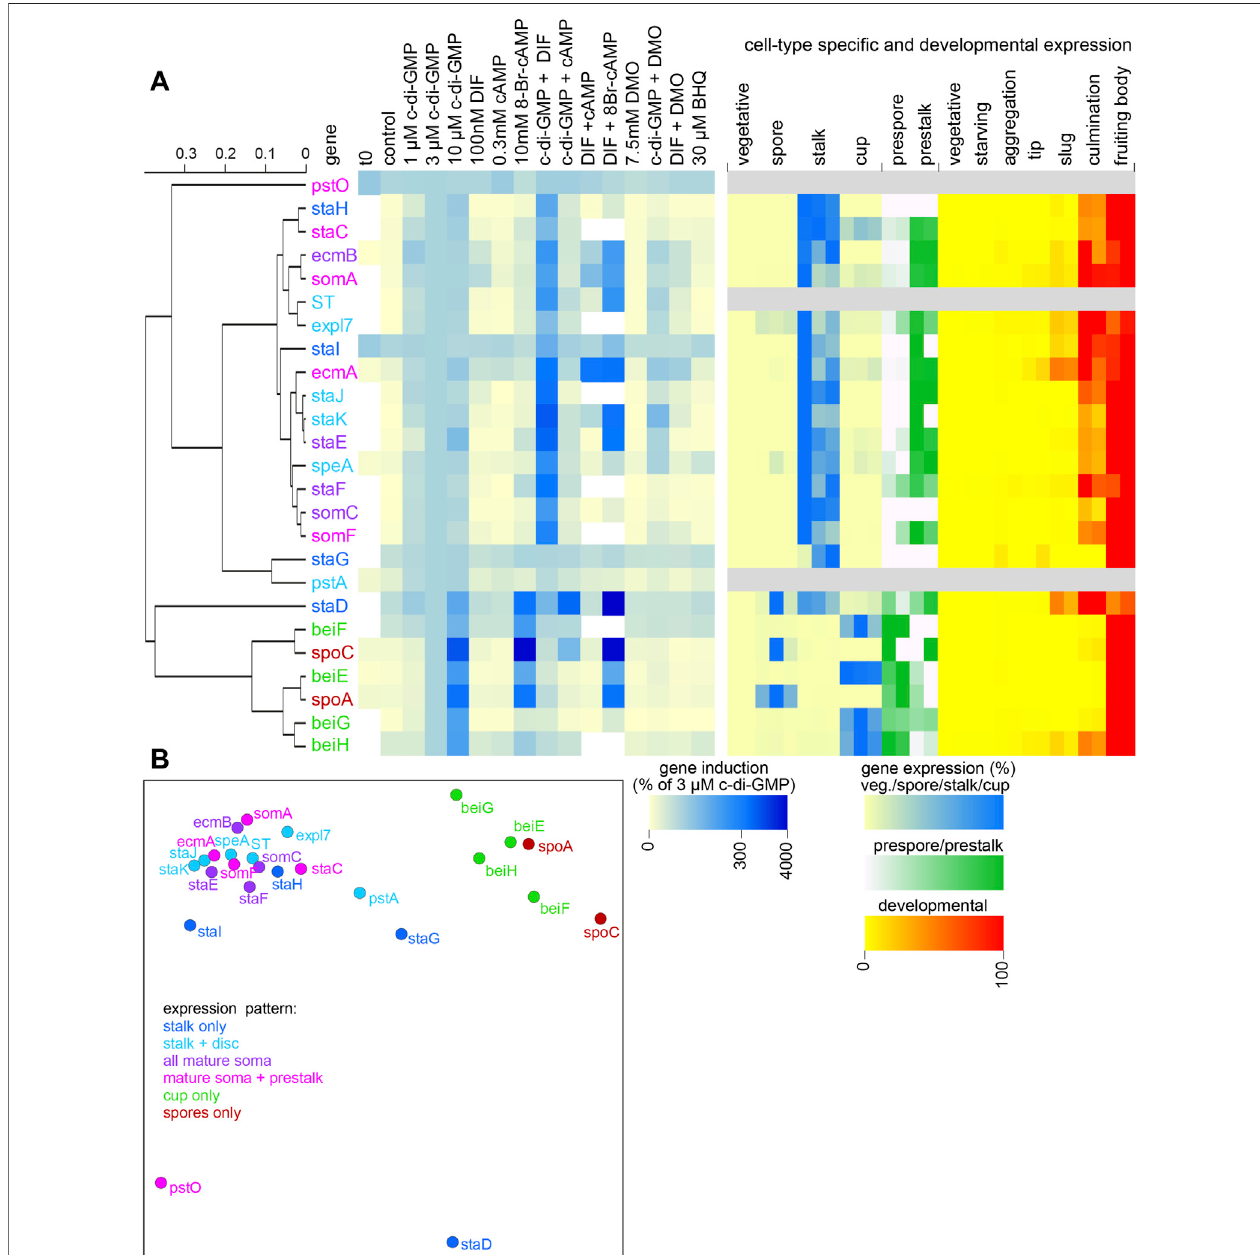
FIGURE3| Clusteranalysisofgene induction data. (A) .Hierarchical tree. Theaveragedgene induction dataof Figure 2 ,expressed aspercentage ofinduction by 3 µM c-di-GMP (also for staD ) were subjected to hierarchical clustering in Orange (Demsar et al., 2013). Distances between genes were determined by Pearson correlation of their responses to the different stimuli and a hierarchical tree was inferred from the distance matrix by average linkage. (A) The tree is annotated with a heatmap of the averaged gene induction responses and a heatmap of the cell-type speci fi c and developmental expression of the genes derived from two or three replicate experiments. (B) . Multidimensional scaling. The induction data were also subjected to multidimensional scaling, an iterative method that yields a two- dimensional projection of points, which minimizes the distances between them. Cluster analysis based on gene induction data expressed as fold-change relative to control (no addition) is shown in Supplementary Figure S7